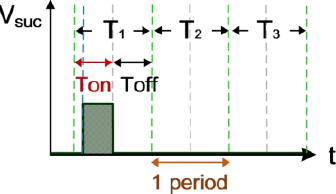
Figure 4. Current I gap : ( a ) I gap and I L , and ( b ) I gap and I L input into the comparator.